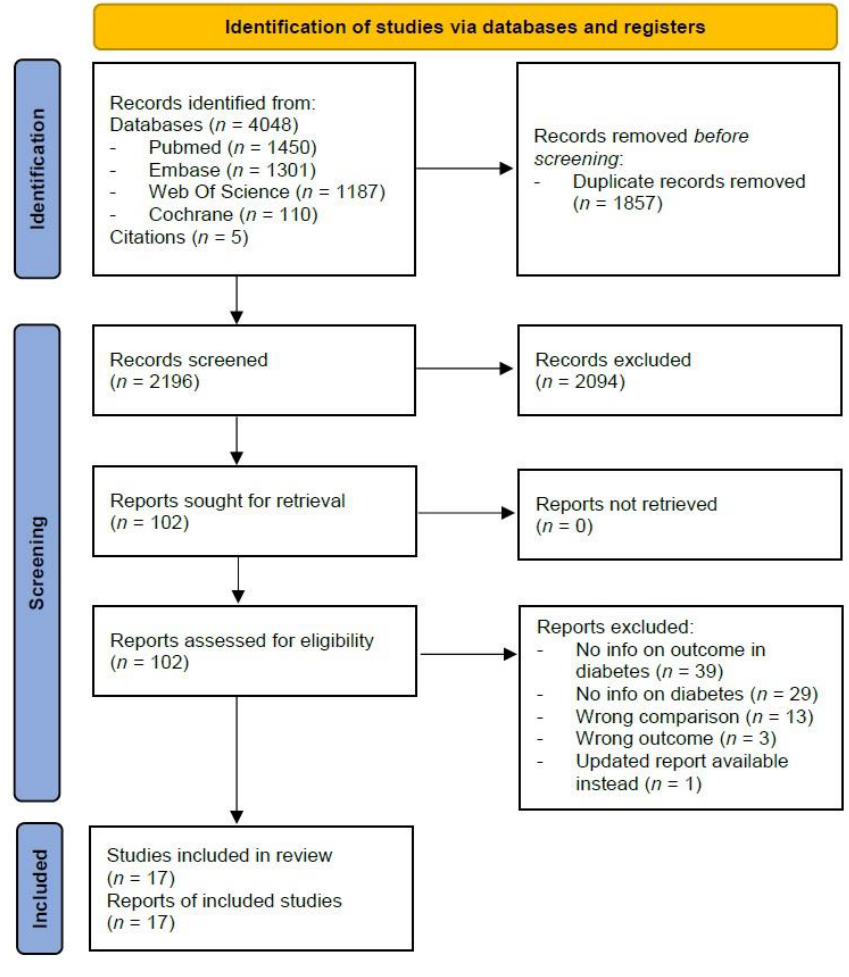
Figure 1. Flowchart of inclusion of studies.